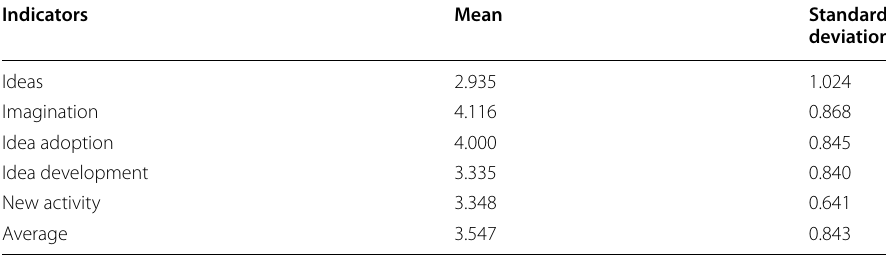
Table 4 Mean score for creativity